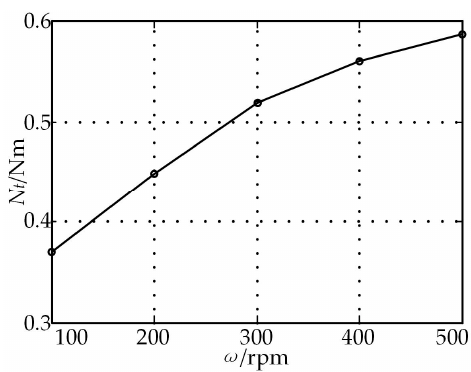
Figure 10. Transmission-resisting torque.